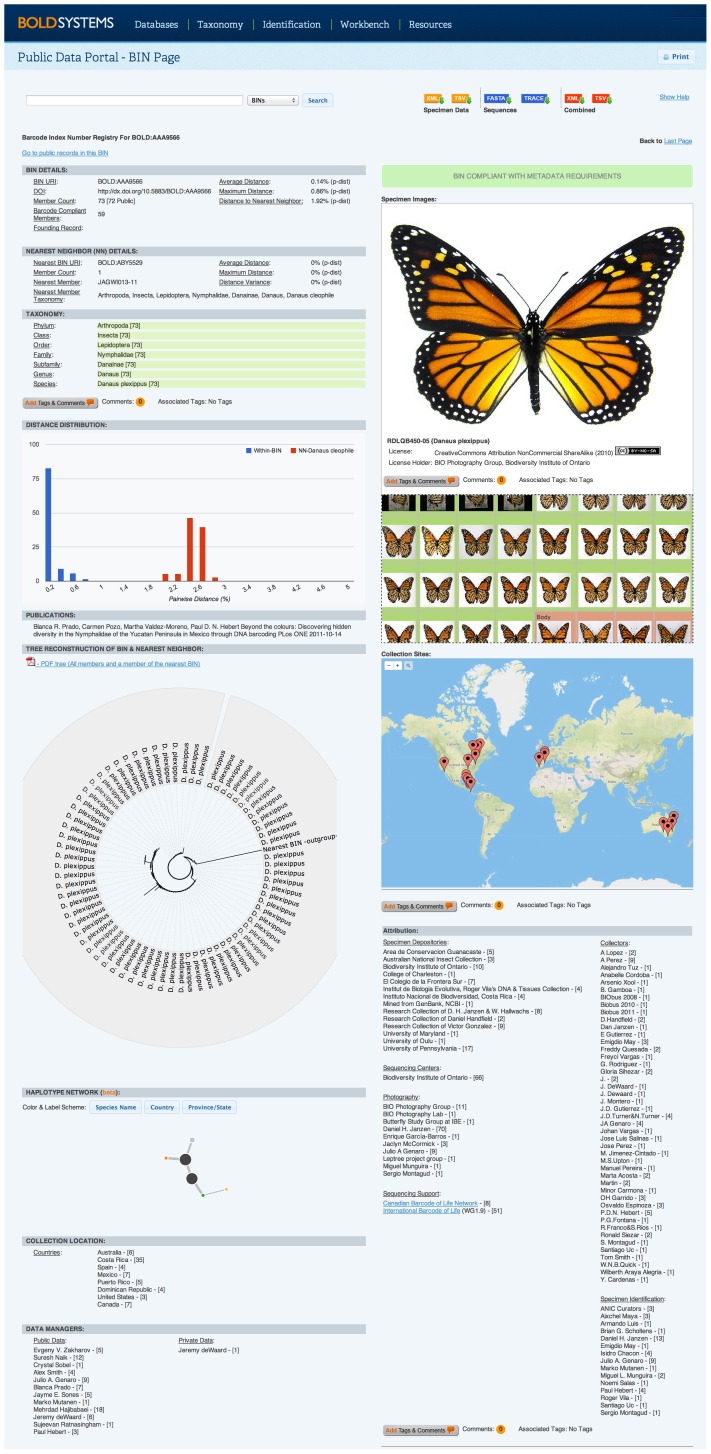
BIN page for Danaus plexippus (Linnaeus, 1758), the monarch butterfly.